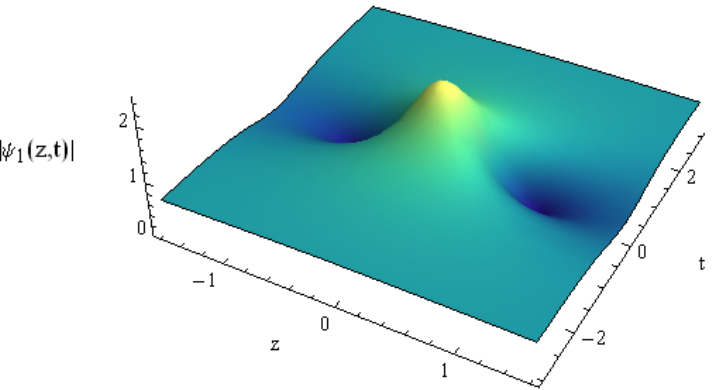
Figure 13. Change of solution (21) with z , t for c = 0.5, v = 0.7, β 2 = 1, β 3 = 0, β 4 =